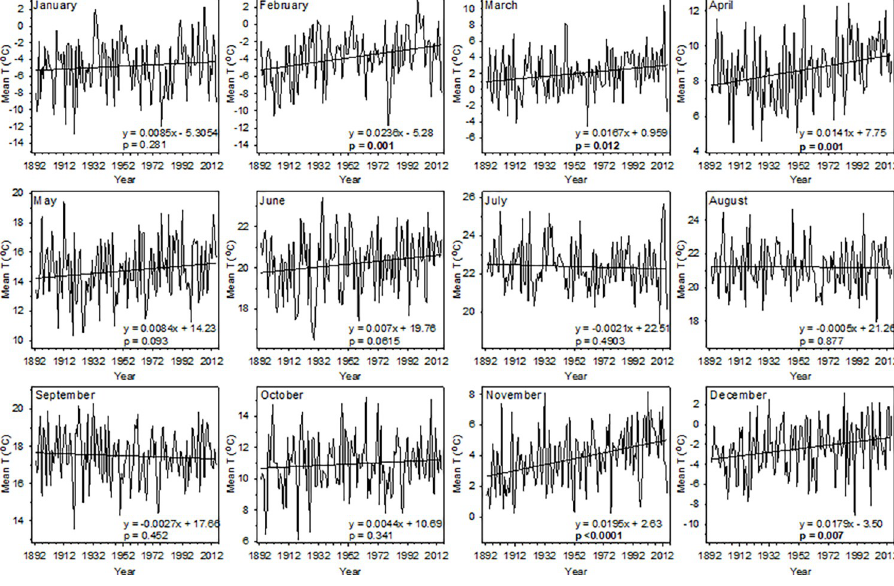
Fig 1. Trends in mean temperature for each month in Wauseon, OH from 1892–2014. Simple linear regressions were used to determine the rate of temperature change in each month (˚C/year) over the 123-year period. Significant p -values are given in